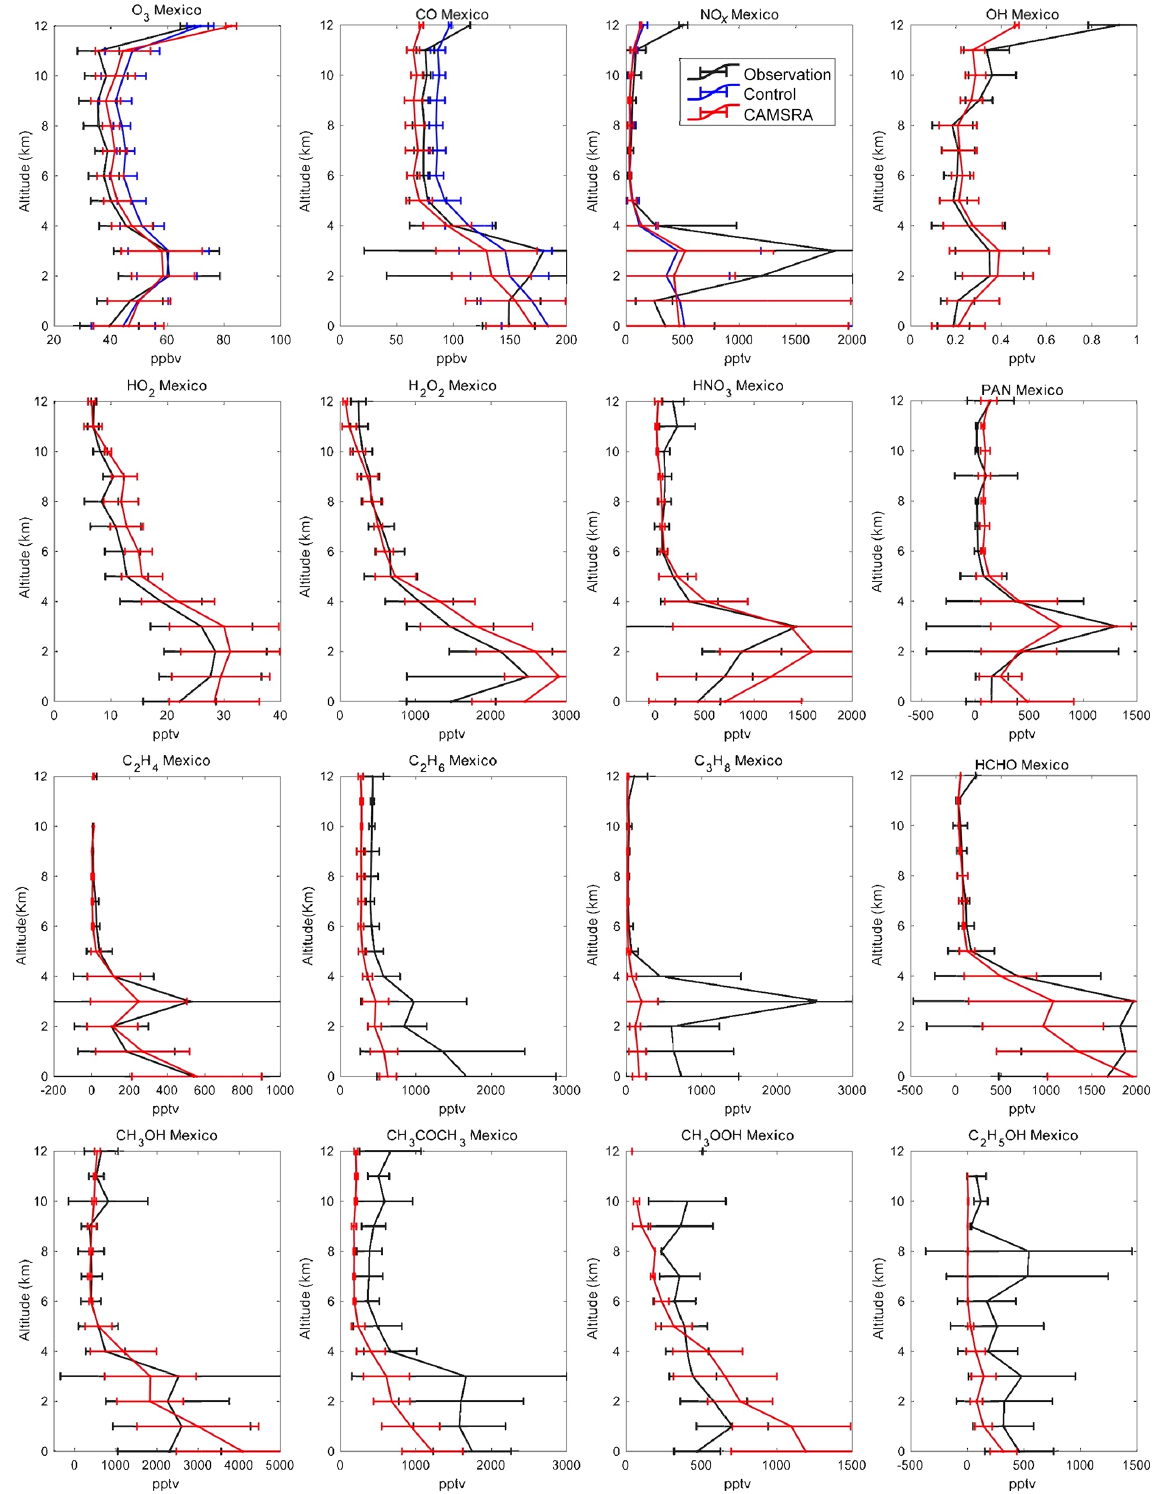
Figure 12. Averaged profiles of the trace constituents over Mexico during the INTEX-B campaign from March to May 2006. The black lines are the observations, the red lines correspond to the CAMSRA reanalysis, and the blue lines are the control run (only shown for O 3 , CO and NO x ). The error bars represent the standard deviation of the data and